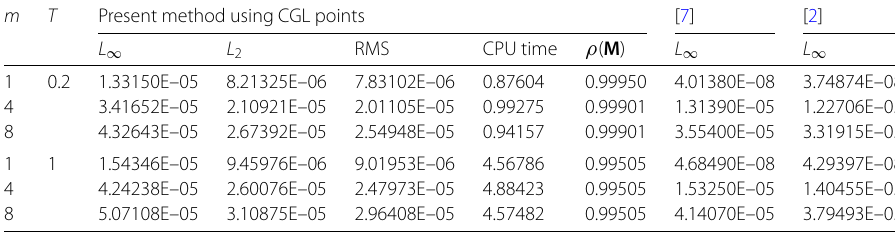
Table 4 Error norms and spectral radius for the solution of Example 1 in Case